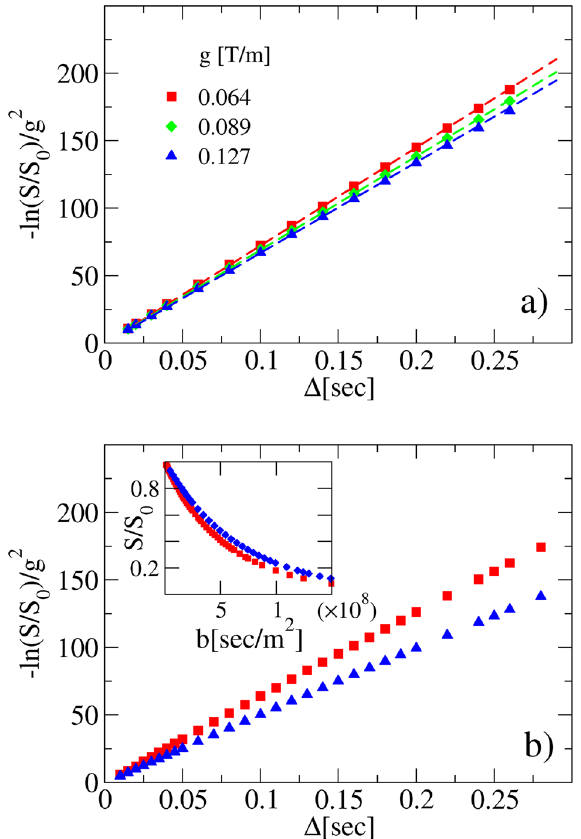
Figure 8. Experimental curve rescaling. DW-NMR signals of water diffusion coming from two different experiments are rescaled according to Fig. 5 (see “Methods”). Panel ( a ) diffusion of water inside water. The rescaled curve obtained at different values of the pulse field gradient strengths g , makes it possible to 9 m 2 / s for g 0.064 T/m, 2.1 10 use the Stejskal–Tanner formula (22). The fitted values of D are D − = = × 9 m 2 / s for g 9 m 2 / s for g 0.089 T/m and D 0.127 T/m with an error of 2.0 10 2.1 10 D − − = = = × = × about 10 − 12 in all cases. The ζ values are of order of 10 5 , meaning that the NPG approximation holds in this 1 . Panel ( b ) DW-NMR attenuation signals of water molecules diffusing in samples filled up with case δζ ≫ polystyrene microbeads mixture with nominal average diameters of 6, 10, 40 µ m 37,39 . Symbols refer to the values of g in Panel ( a ). The lack of collapse between the rescaled curves does not allow the use of the anomalous expression (24) for fitting. Inset: the same DW-NMR attenuation signals of panel ( b ) are plotted versus b value, showing a no solid